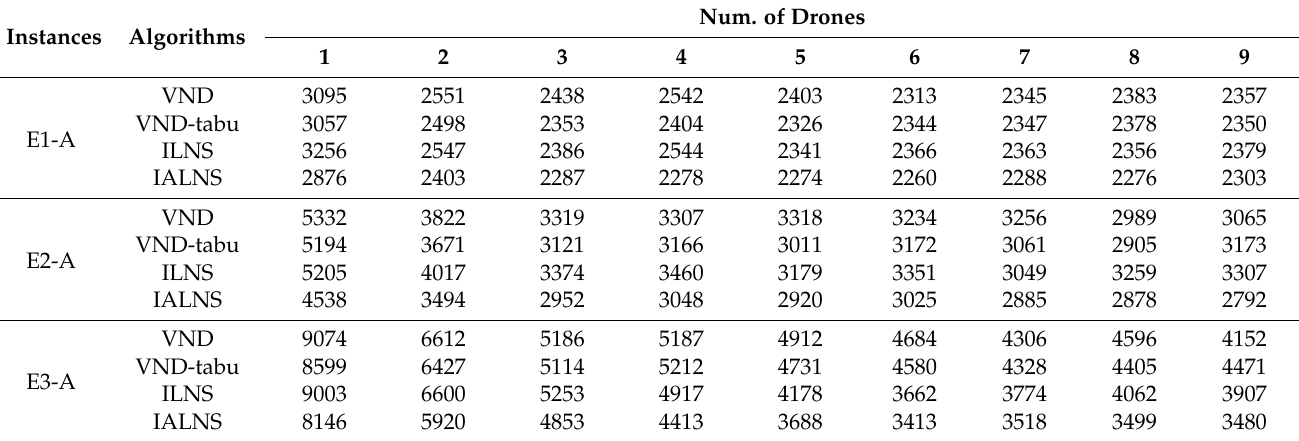
Figure 14. Impact of different number of drones on experimental results. ( a )E1-A; ( b ) E2_A; ( c ) E3-A. Table 7. Experimental results of each algorithm under different number of drones.